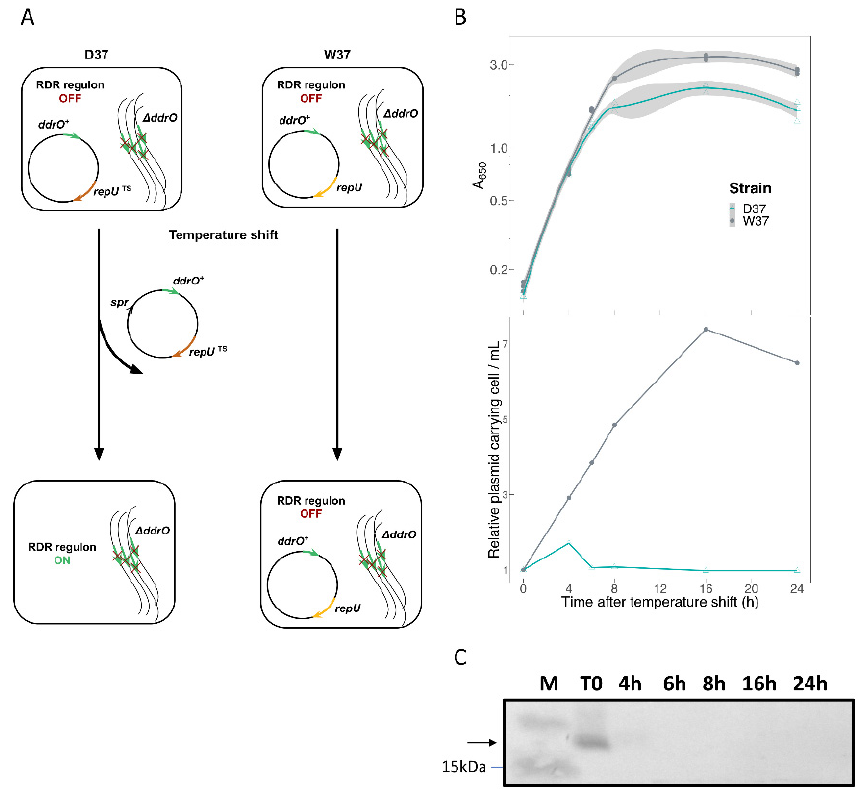
Figure 3. Loss of the repU TS vector in a chromosomal ∆ ddrO context. ( A ). Experimental design. Expression of RDR regulon genes was induced at 37 ◦ C when the thermosensitive replicative vector expressing DdrO could no longer replicate. ( B ). Growth parameters of W37 (grey line) and D37 (blue line) strains, and relative stability of the repU T s or the repU + replication vectors expressing DdrO at 37 ◦ C during a 24 h period. The A 650nm values of the cultures were measured in 3 independent experiments (confidence interval for each smoothed curve is indicated in light grey area). To calculate vector stability, samples were removed at the indicated times for plating at 30 ◦ C on media with or without spectinomycin. ( C ). Western blot analysis of recombinant DdrO-FLAG protein depletion in D37 at 37 ◦ C. At each time point, aliquots of cells were removed and cell extracts (15 µ g of proteins) were subjected to SDS-PAGE and analyzed by Western blot with anti-FLAG antibodies. The indicated times are relative to the initial temperature shift time point (0